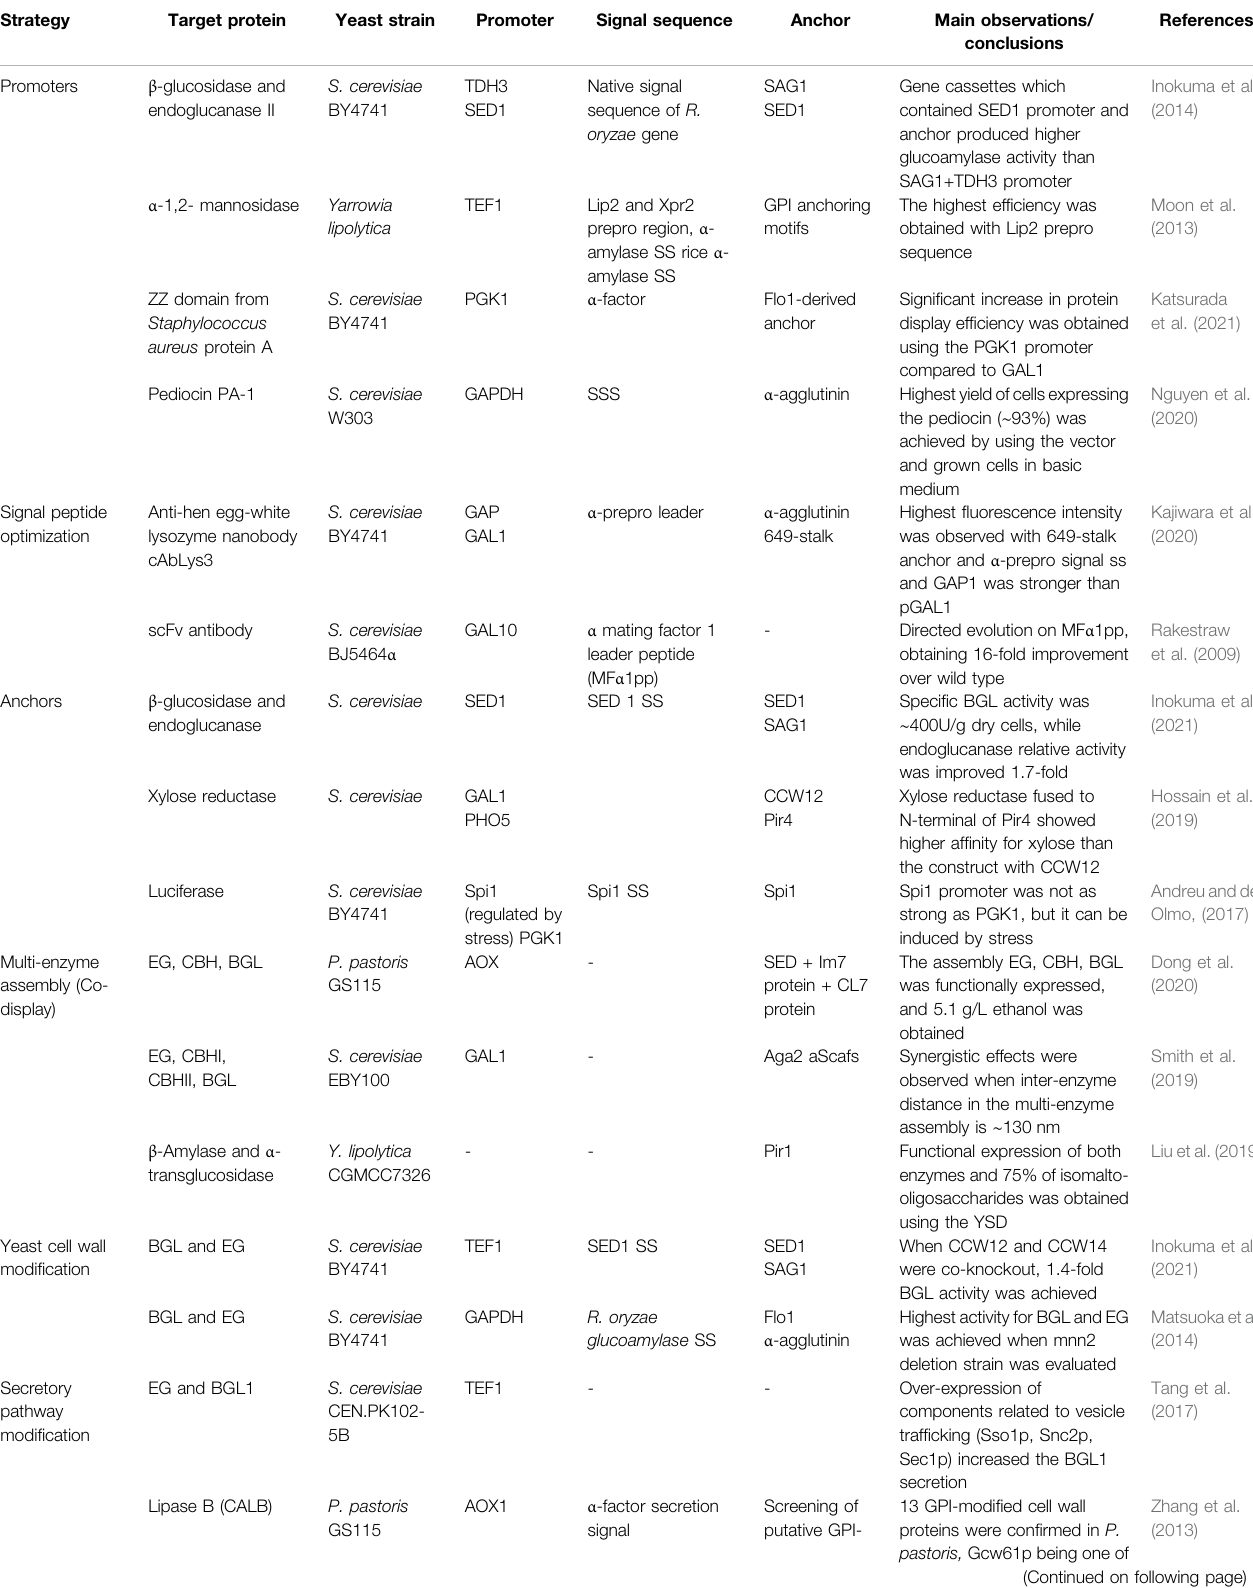
TABLE 1 | Strategies focused on key factors that affect the displayed protein